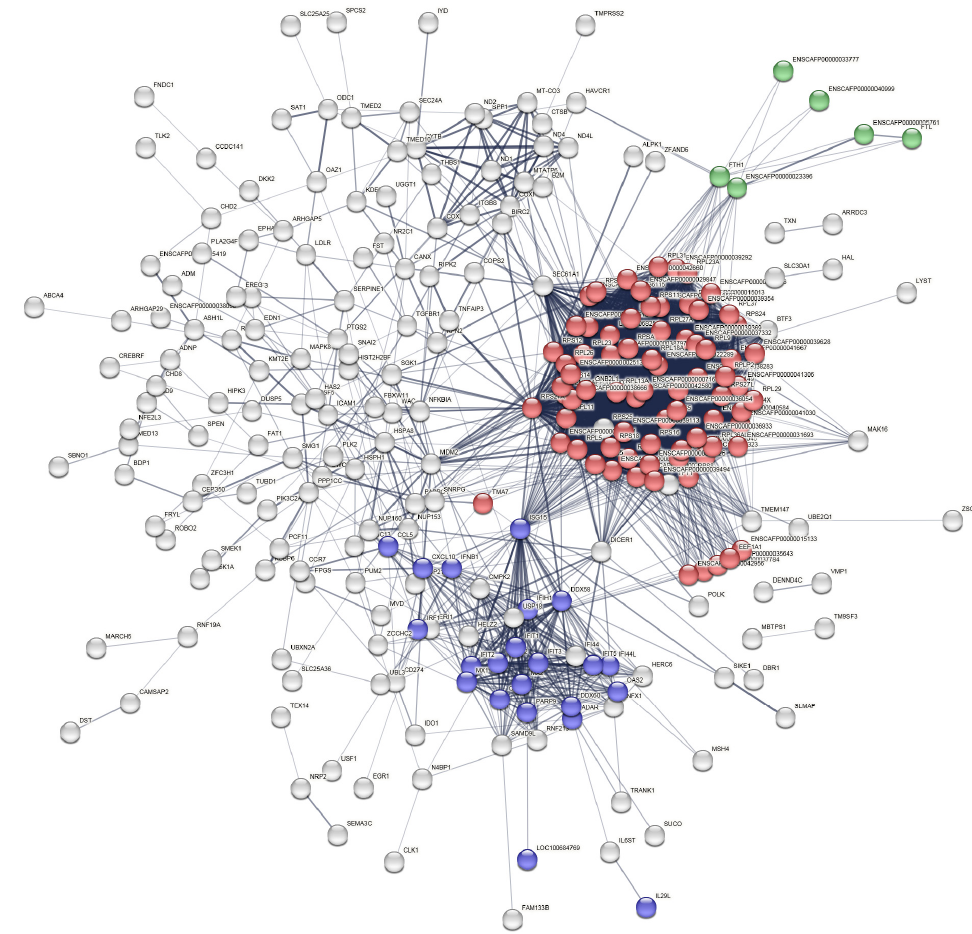
Figure 5. The interaction network of proteins encoded by transcripts overexpressed in exosomes isolated from IAV-infected MDCK cells, STRING pathway analysis. Colors indicate GO annotations: red—GO:0006412 “Biological process—Translation”; blue—GO:0009615 “Biological process— Response to virus”; green—GO:0006880 “Biological process—Intracellular sequestering of iron ion”; white—not assigned to a specific process.